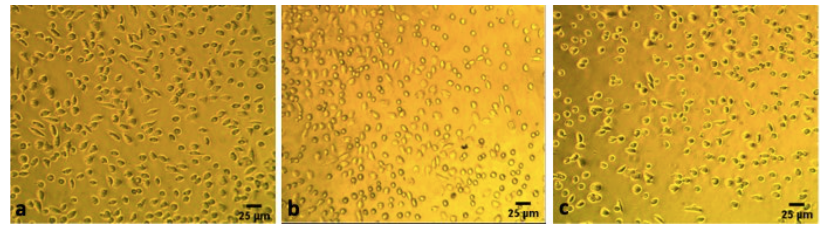
Figure 2. The morphological views of cells. Experimental Groups: ( a ) Fill-Up!™ polymerized with VALO™ Cordless LCU, ( b ) ACTIVA™ BioACTIVE-RESTORATIVE™ polymerized with VALO™ Cordless LCU, and ( c ) HyperFIL ® HAp polymerized with VALO™ Cordless. The scale bar in each image equals to 25 μm.